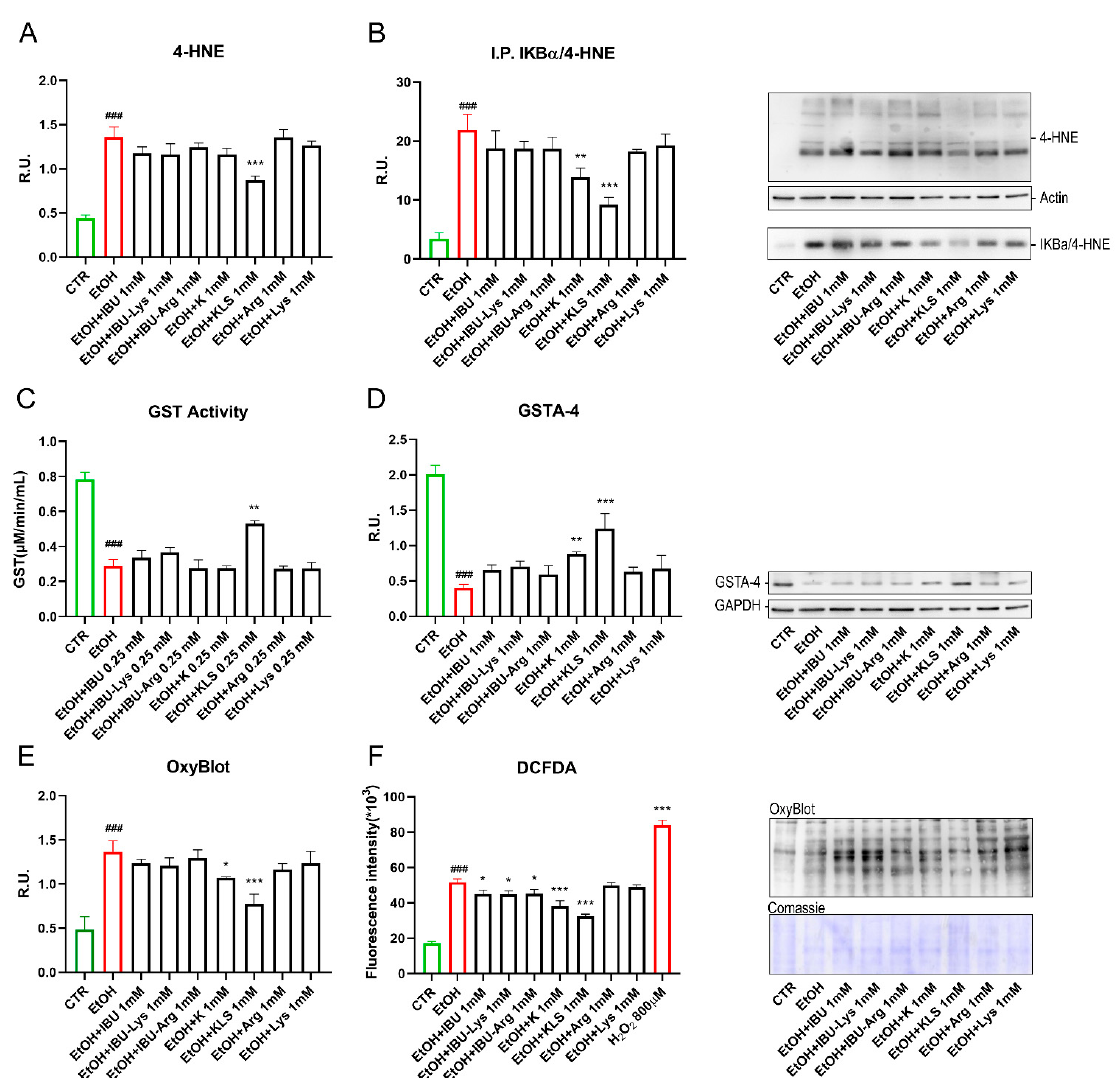
Figure 5. ( A ) WB analysis for 4-HNE on Caco-2 cells after EtOH (6% for 24 h), EtOH + IBU, EtOH + IBU-Lys, EtOH + IBU-Arg, EtOH + K, EtOH + KLS, EtOH + Arg, and EtOH + Lys treatments (1 mM for 72 h). Data are mean ± SD of 3 different experiments. ( B ) Immunoprecipitation for IKB α on Caco-2 cells after EtOH, EtOH + IBU, EtOH + IBU-Lys, EtOH + IBU-Arg, EtOH + K, EtOH + KLS, EtOH + Arg, and EtOH + Lys treatments (1 mM for 72 h). A representative western blot image is reported. ( C ) GST activity analyzed by ELISA assay on Caco-2 cells after EtOH (6% for 24 h), EtOH + IBU, EtOH + IBU-Lys, EtOH + IBU-Arg, EtOH + K, EtOH + KLS, EtOH + Arg, and EtOH + Lys treatments (1 mM for 72 h). ( D ) WB analysis for GSTA-4 on Caco-2 cells after EtOH (6% for 24 h), EtOH + IBU, EtOH + IBU-Lys, EtOH + IBU-Arg, EtOH + K, EtOH + KLS, EtOH + Arg, and EtOH + Lys treatments (1 mM for 72 h). A representative western blot image is reported. ( E ) OxyBlot assay to assess the intracellular oxidized protein on Caco-2 cells after EtOH (6% for 24 h), EtOH + IBU, EtOH + IBU-Lys, EtOH + IBU-Arg, EtOH + K, EtOH + KLS, EtOH + Arg, and EtOH + Lys treatments (1 mM for 72 h). A representative OxyBlot image is reported. ( F ) DCFDA assay of Caco-2 upon EtOH (6% for 24 h), EtOH + IBU, EtOH + IBU-Lys, EtOH + IBU-Arg, EtOH + K, EtOH + KLS, EtOH + Arg and EtOH + Lys treatments. Data are mean ± SD of 3 different experiments. One way ANOVA was performed: ***, p < 0.0001; **, p < 0.005; *, p < 0.05 vs. EtOH; ###, p < 0.0001 EtOH vs. CTR. Oxidative stress and oxidized protein overload affect proteasome activity. Polyubiq- uitin chains linked via lysine 48 (K48) are the most abundant and represent the